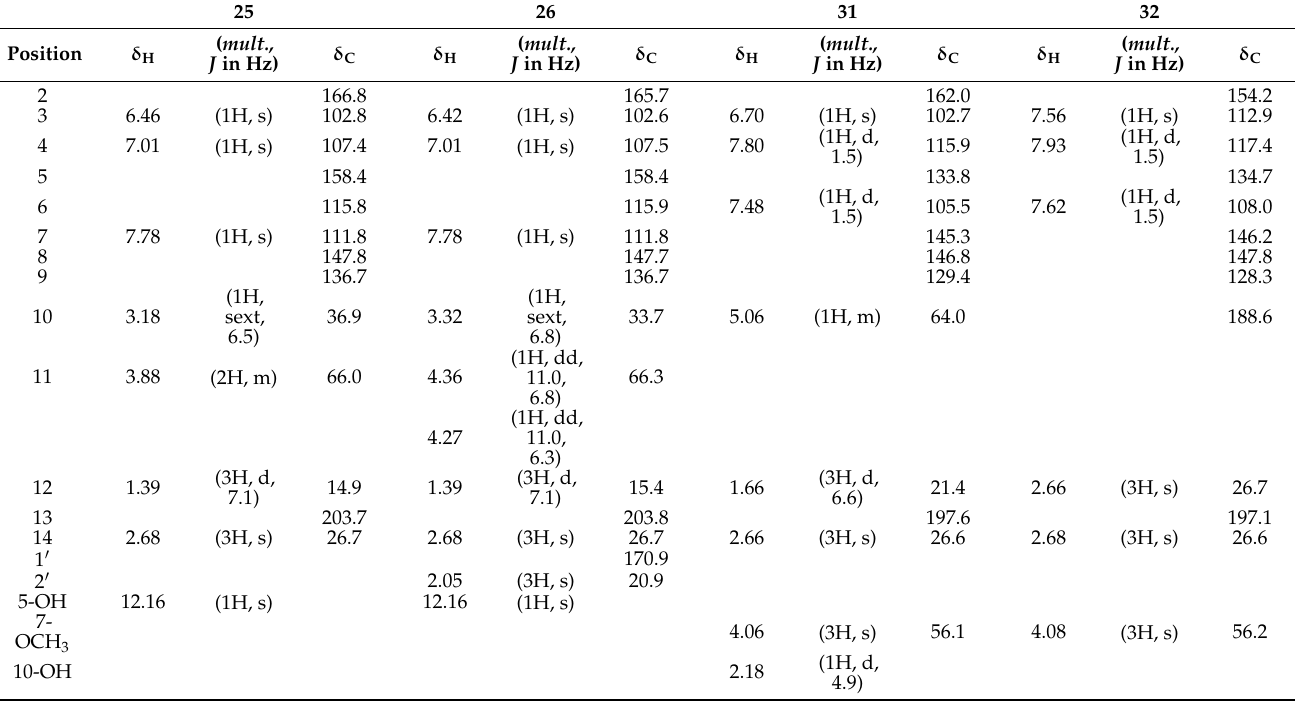
Table 4. 1 H (500 MHz) and 13 C (126 MHz) NMR data of 25 , 26 , 31 , and 32 in CDCl 3